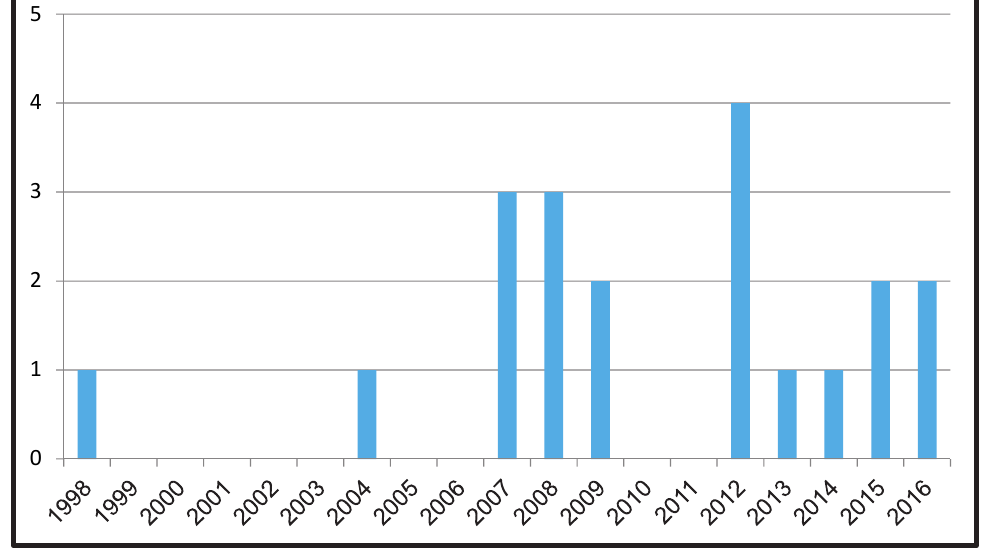
Fig. 2. Time Distribution